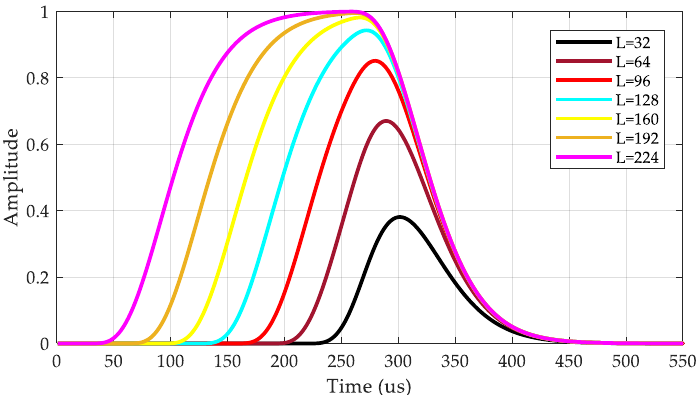
Figure 6. Correlation peaks at different correlation lengths.